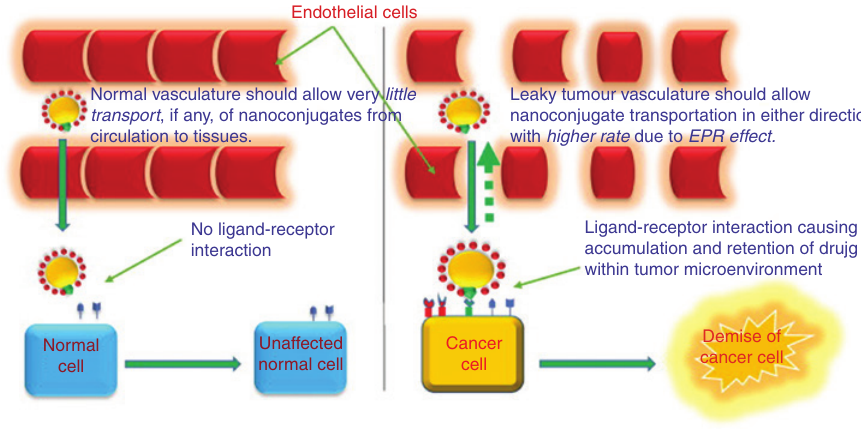
Figure 1: Different biological responses mediated by receptor ligands and the resulting cellular fate in cancer vs. normal cells. Ligand deco- rated nanoconjugates would in principle gradually concentrate within tumor tissues due to the higher leakage mediated by the enhanced permeability and retention (EPR) effect and the consequent entrapment caused by ligand binding with overexpressed receptors in cancer cells. Reprinted from Akhtar et al. [11]. Copyright (2014), with permission from